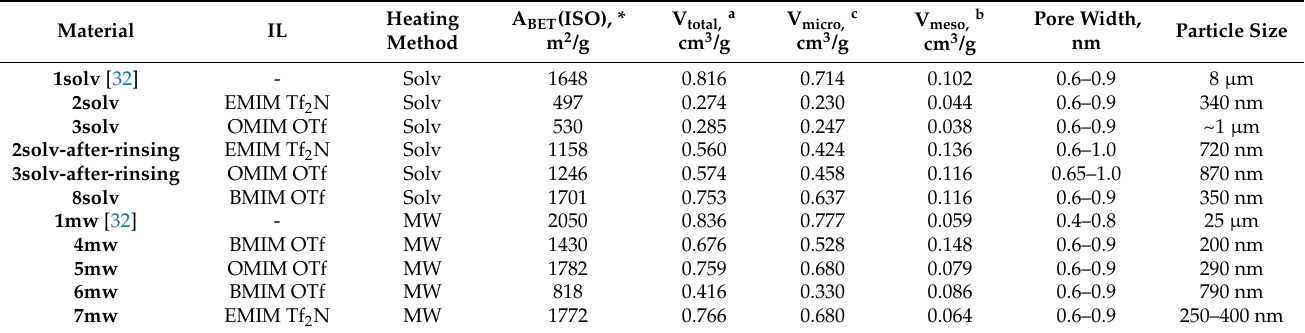
Table 2. Textural properties and particle size of the synthesized HKUST-1